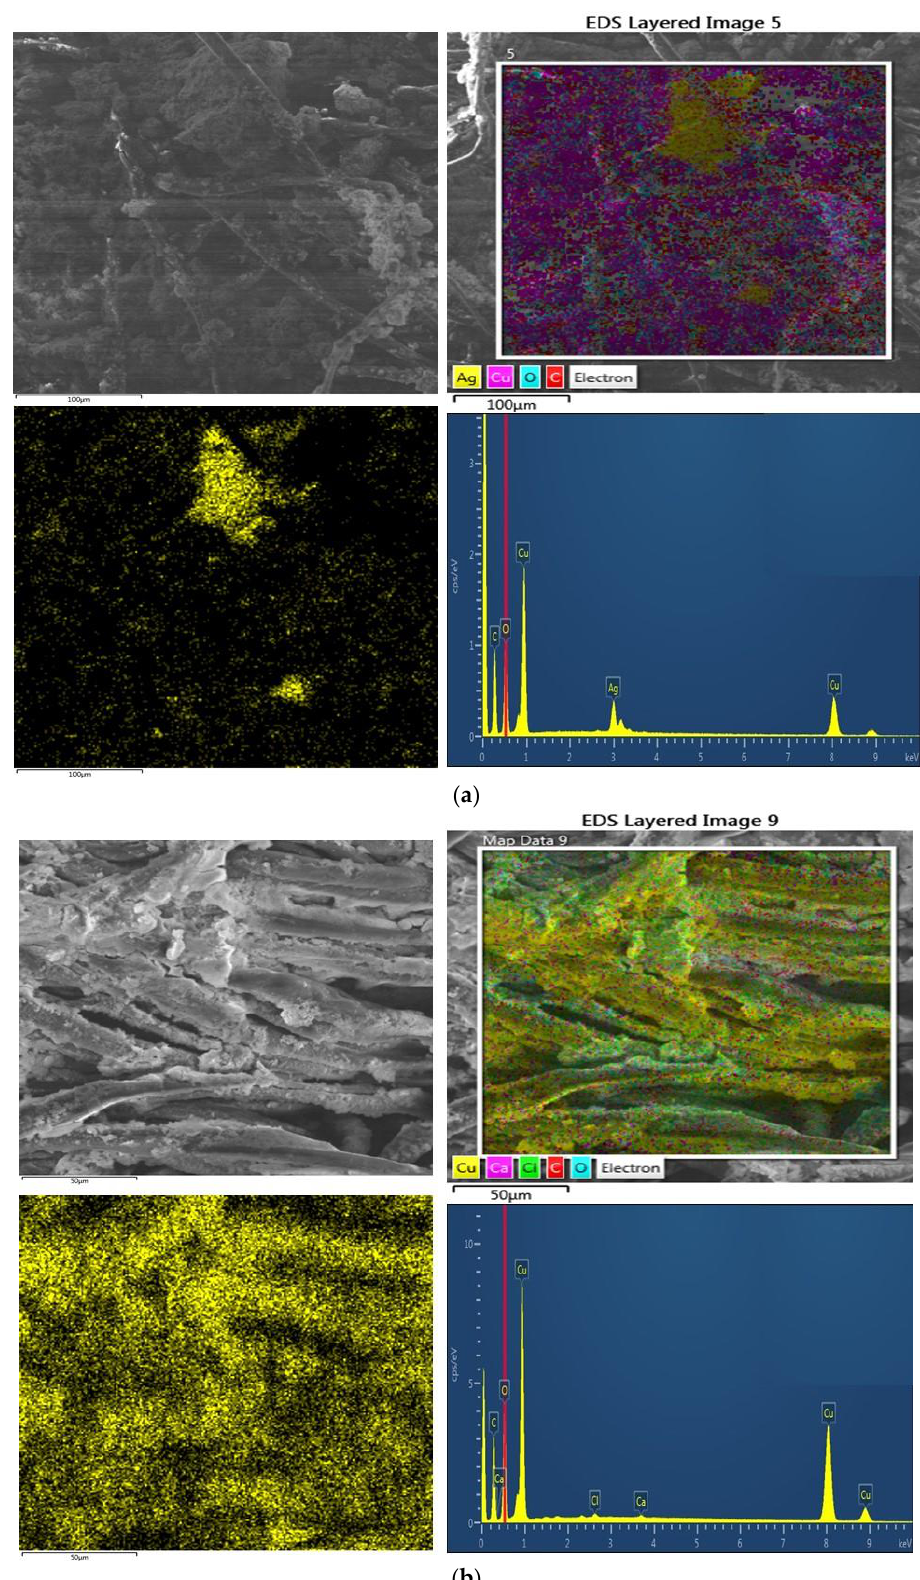
Figure 11. SEM image of ( a )copper electro-plating over the silver particle-coated fabric (A9) and ( b ) copper electro-plating over copper particle-coated fabric (C9).